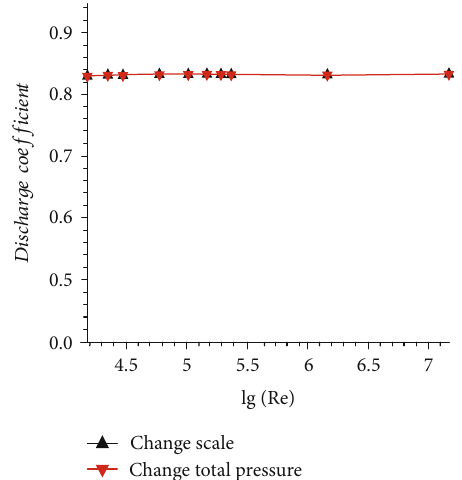
Figure 13: Comparison of the discharge coe ffi cients obtained by changing the scale and total